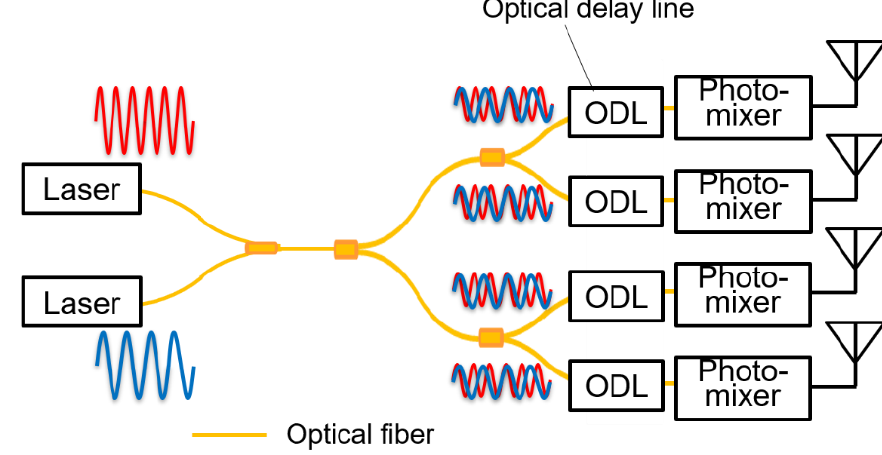
Figure 4. Configuration of 4-arrayed photomixing system.